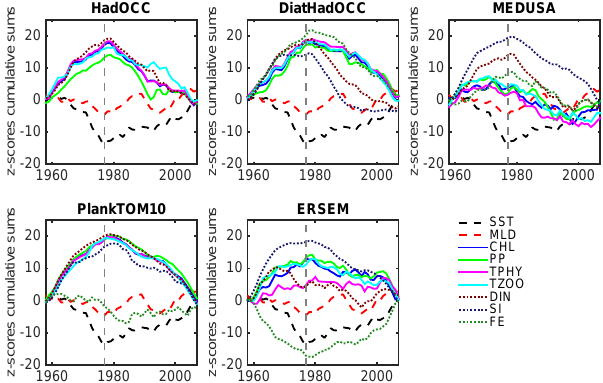
Figure 5. Cumulative sums of the z scores of simulated sea surface temperature (SST), mixed-layer depth (MLD), surface dissolved in- organic nitrogen (DIN), silica (SI), iron (FE), surface chlorophyll (CHL), integrated primary production (PP), total surface phyto- plankton (PHY) and zooplankton (ZOO) biomass for each model averaged over the Gulf of Alaska region. Z scores are calculated by subtracting the mean and dividing by the standard deviation of each time series. Cumulative sums of the z scores are then calculated. The vertical lines in 1977 provide a guide to the eye showing where the slopes change after 1977.